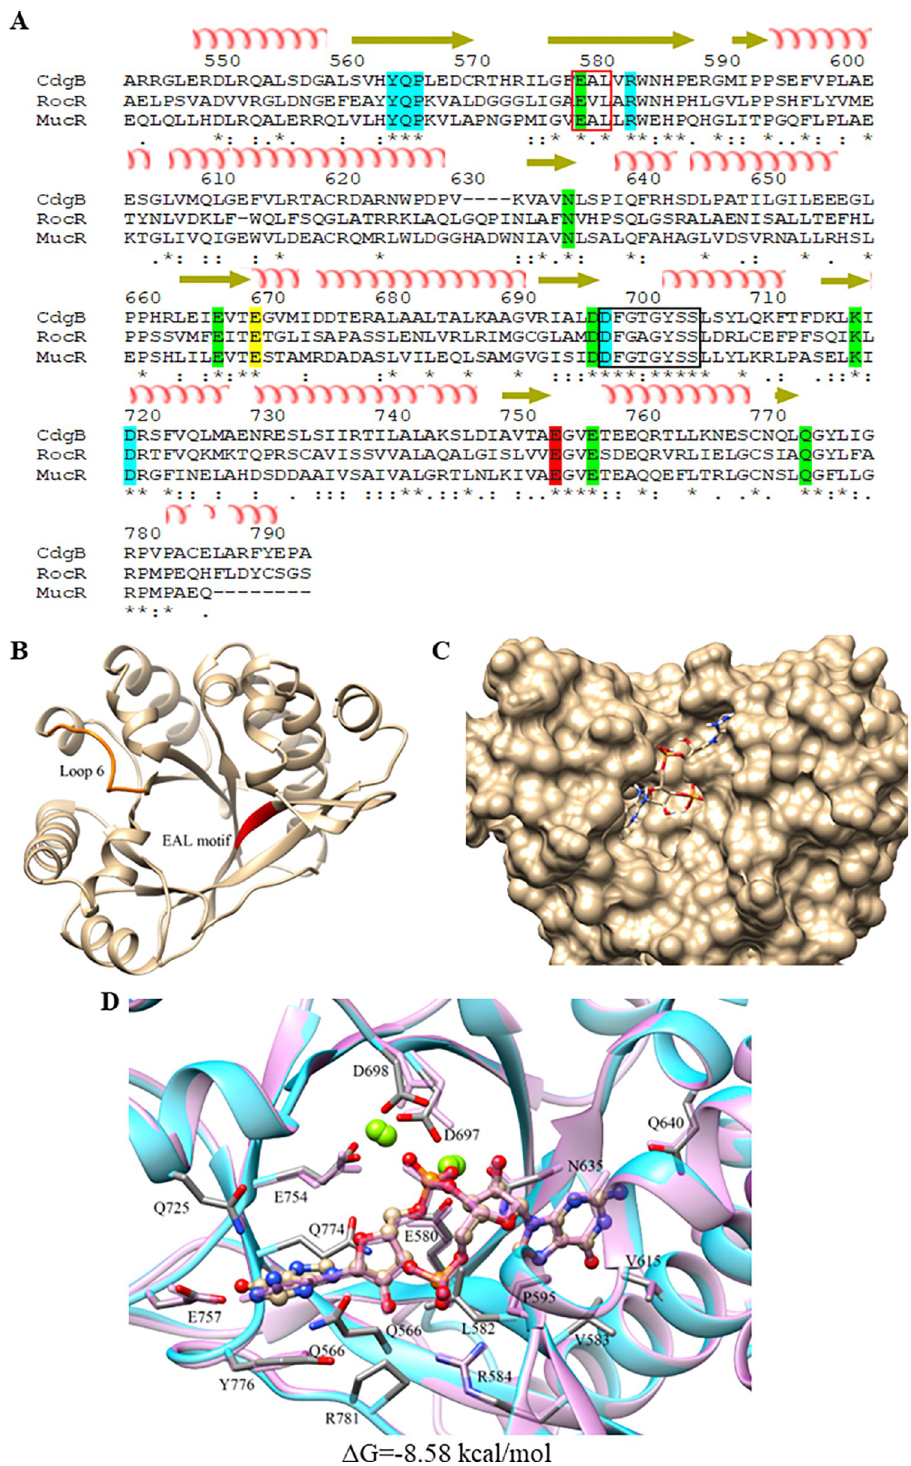
Fig 3. CdgB EAL domain structure. (A) Sequence alignment between CdgB EAL domain from A . baldaniorum Sp245 (GenBank access number CCD03171.1) and other EAL domains of known structure. RocR, (GenBank access number NP_252636.1), and MucR (GenBank access number AAG05116.1) from P . aeruginosa . Secondary structure elements are displayed above the sequences. The residues highlighted in blue are involved in the interaction with the substrate. Those that interact with cofactor are marked in green. The residue that stabilizes structurally the loop 6 is shown in